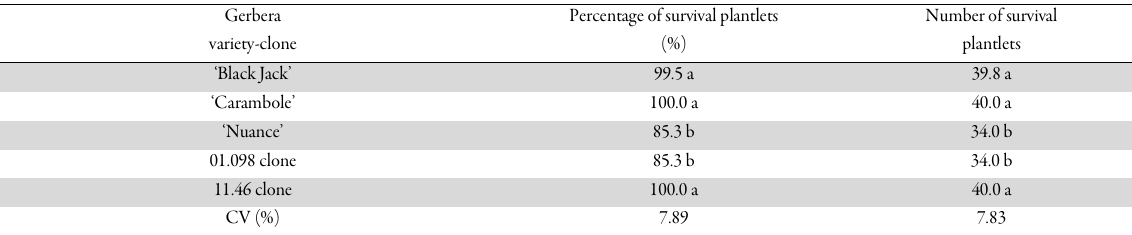
Table 9. Data of plantlet